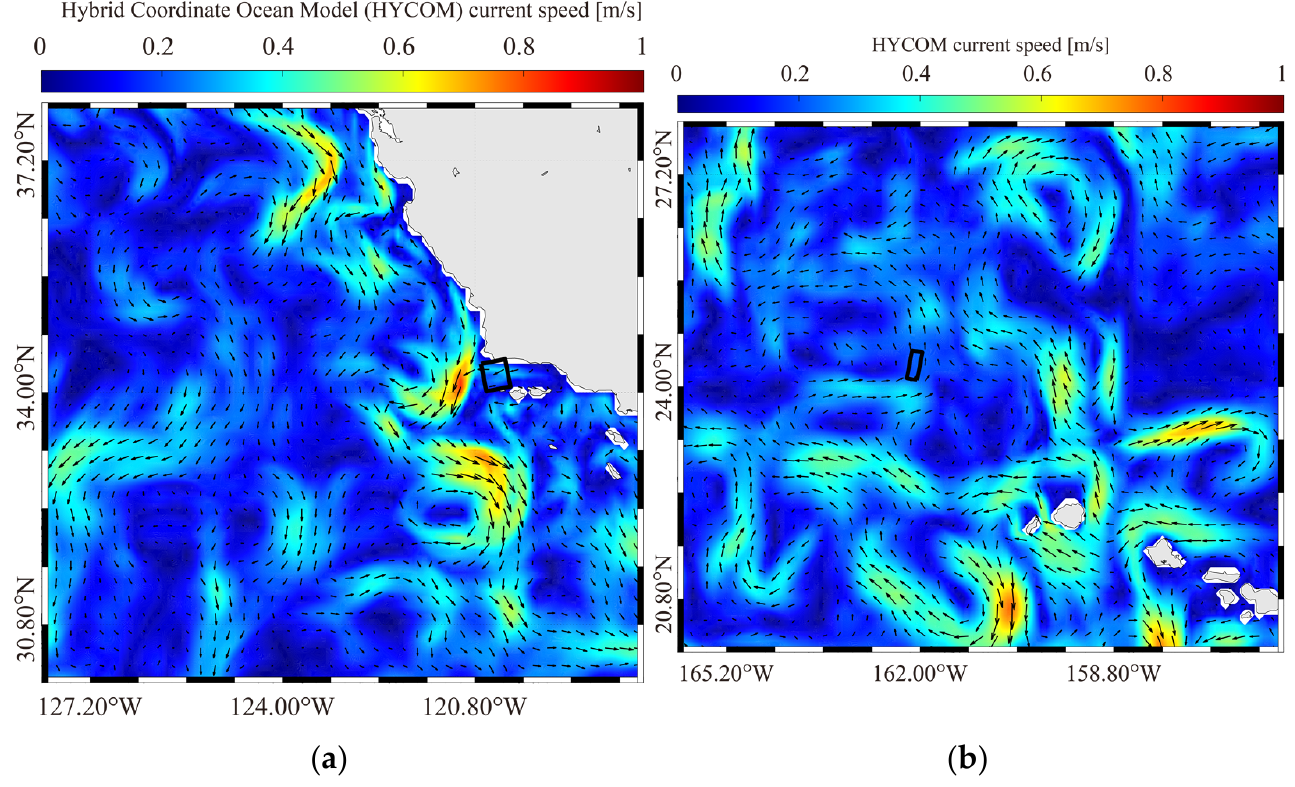
Figure 3. ( a ) The HYbrid Coordinate Ocean Model (HYCOM) sea surface current map at 3:00 UTC on 5 May 2017; and ( b ) The HYCOM sea surface current map at 18:00 UTC on 3 August 2009. The black rectangle denotes the spatial coverage of two images in Figure 1.